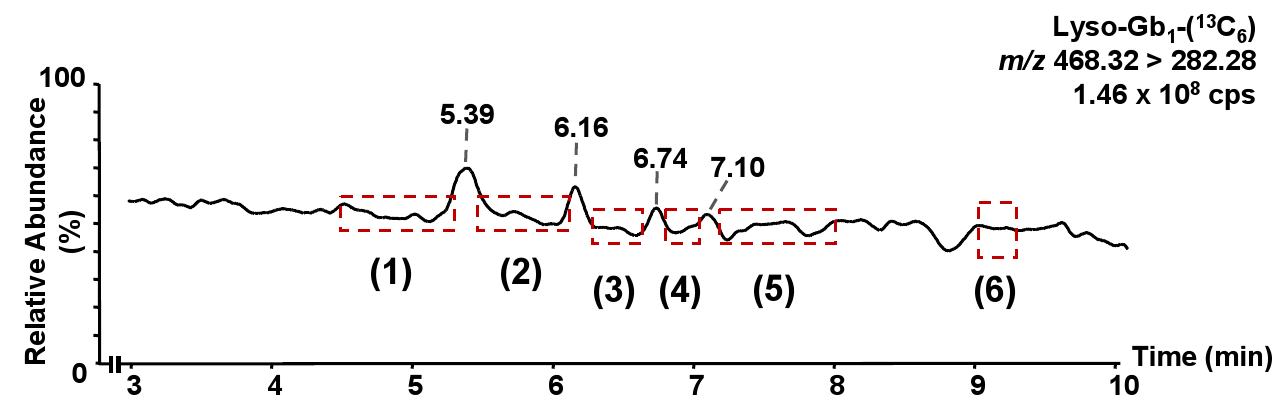
Figure 4. Post-column infusion of lyso-Gb 1 -( 13 C 6 ) (1 µ g/mL; 0.15 µ L/min) during the injection of a healthy control plasma sample. The matrix effect in the elution regions of the biomarkers analyzed was estimated to be < 15% for all analytes. In ( 1 ) elution region for lyso-Gb 1 and lyso-Gb 1 -( 13 C 6 ), as well as analogs − 28, +14, +16 (A), and +30 Da. In ( 2 ) elution region for − 12 (A), +2, +14, +16 (A), and +16 Da (B). In ( 3 ) elution region for polycyclic analog 390 Da, analogs − 26, and − 12 Da (B). In ( 4 ) elution region for analog +32 Da. In ( 5 ) polycyclic analogs 362 and 394 Da while polycyclic analog 366 Da elutes in the region ( 6 ).